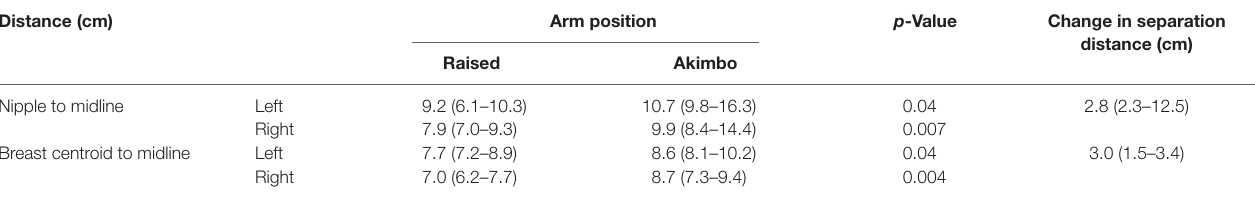
TaBle 2 | arm position-related changes in breast position and separation.